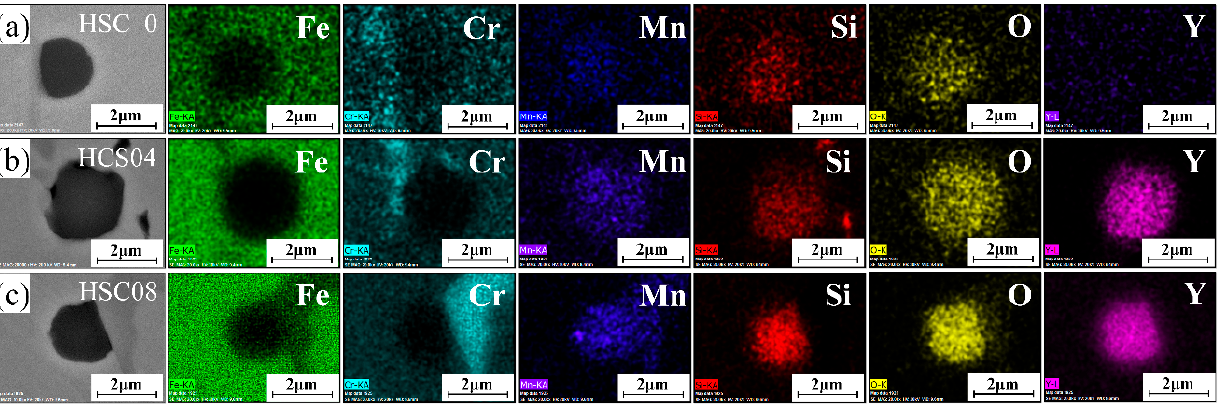
Figure 5. Backscattered electron image and the element composition of secondary phase in the